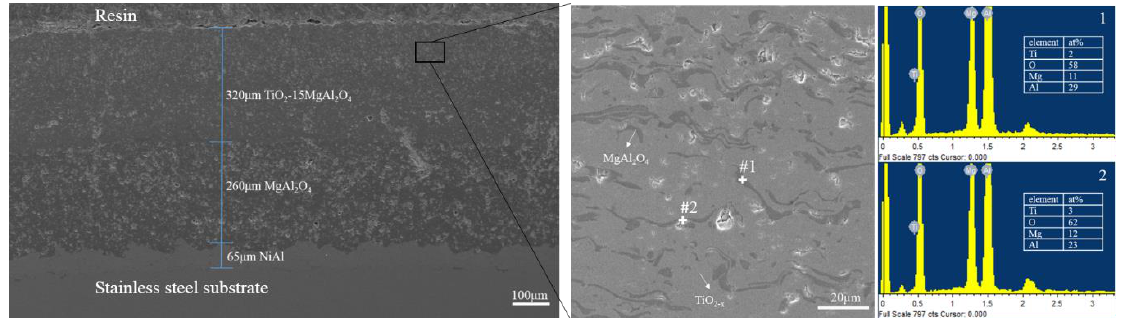
Figure 3. SEM images of TiO 2 -15MgAl 2 O 4 coating surface. (a) low magnification ; (b) high magnification Figure 4. Cross-sectional morphology of electrical-heating coating and EDS analysis.